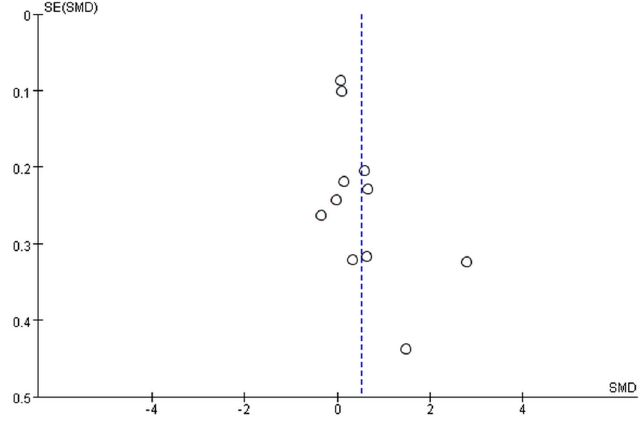
Fig 6. Funnel plot after removing the study with the highest levels of TGF- β